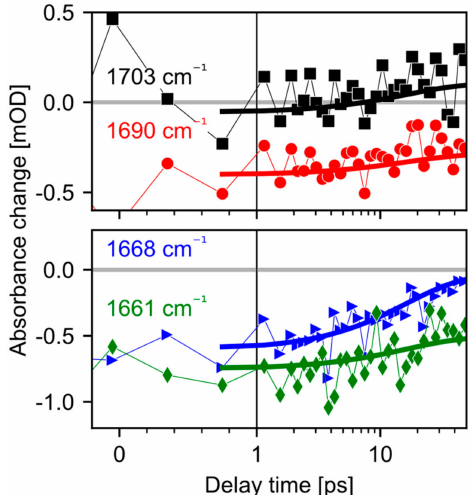
Figure 3. Transients for parallel polarization of pump and probe comparing the dynamics of the protein bands in the amide I and carboxyl region. Symbols represent raw data while the thick lines display the fitted model. The slight decay of the amide I bleaching band at 1661 cm − 1 (green diamonds) is likely caused by the rise of the adjacent 1668 cm − 1 band (blue triangles). The process is accompanied by the rise of the 1703 cm − 1 band (black squares). On the same timescale, the negative band near 1690 cm − 1 (red circles) remains nearly